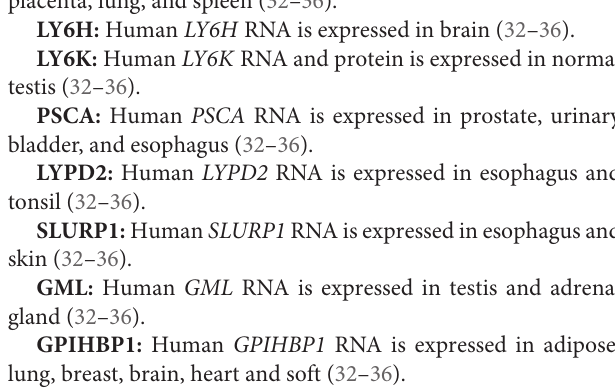
Frontiers in Immunology |